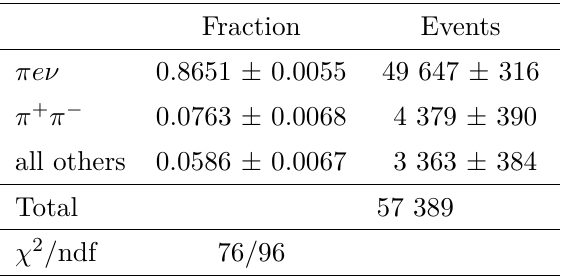
Table 3 . Result of the fit to the m 2